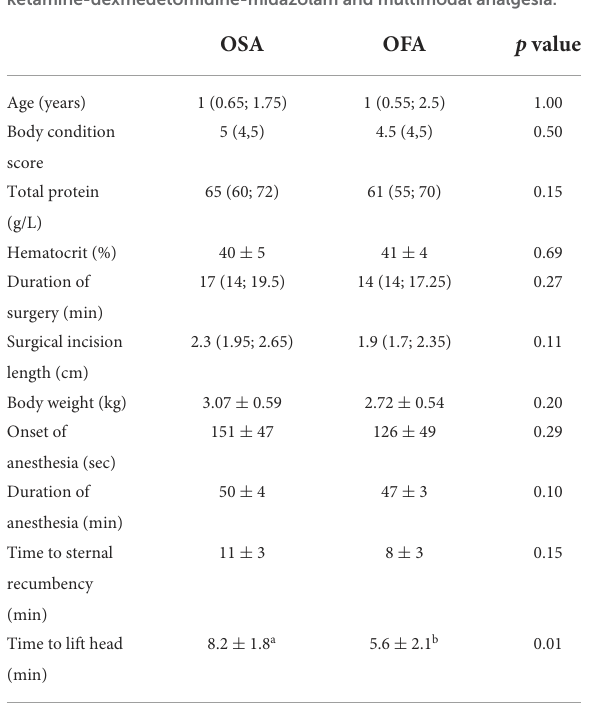
TABLE 1 Population characteristics of cats undergoing ovariohysterectomy after the administration of buprenorphine (OSA) or saline (OFA) by the intramuscular route in combination with ketamine-dexmedetomidine-midazolam and multimodal analgesia.